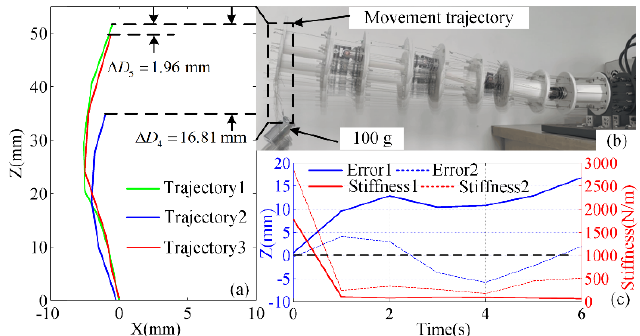
Figure 11. Dynamic stiffness experiments: ( a ) the displacement changes at the manipulator’s end for the three trajectories, ( b ) the manipulator’s full trajectories, and ( c ) the position errors of the manipulator’s end.